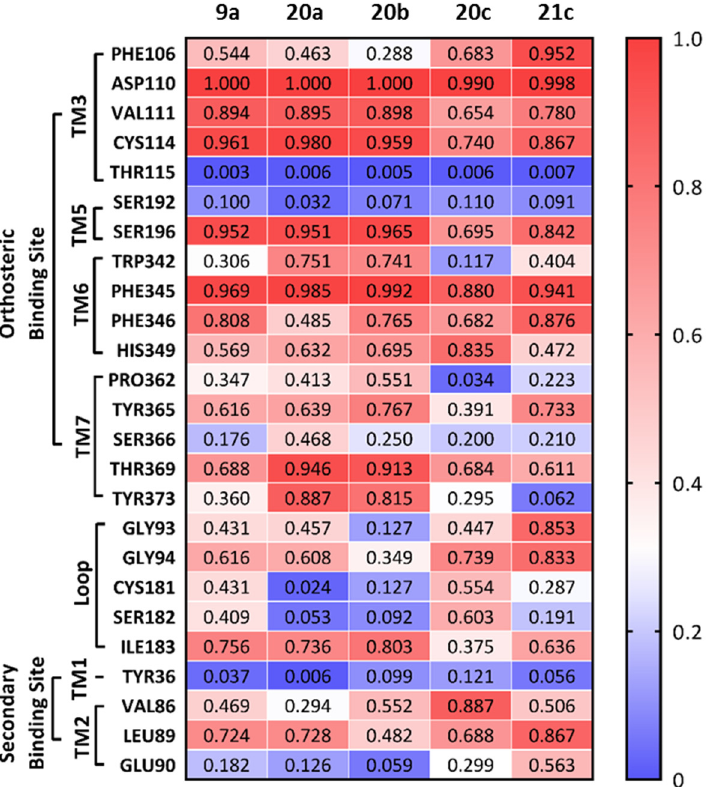
Figure 2. Summary of frequency of all contacts between selected ligands and residues in the D 3 receptor binding sites (the OBS and